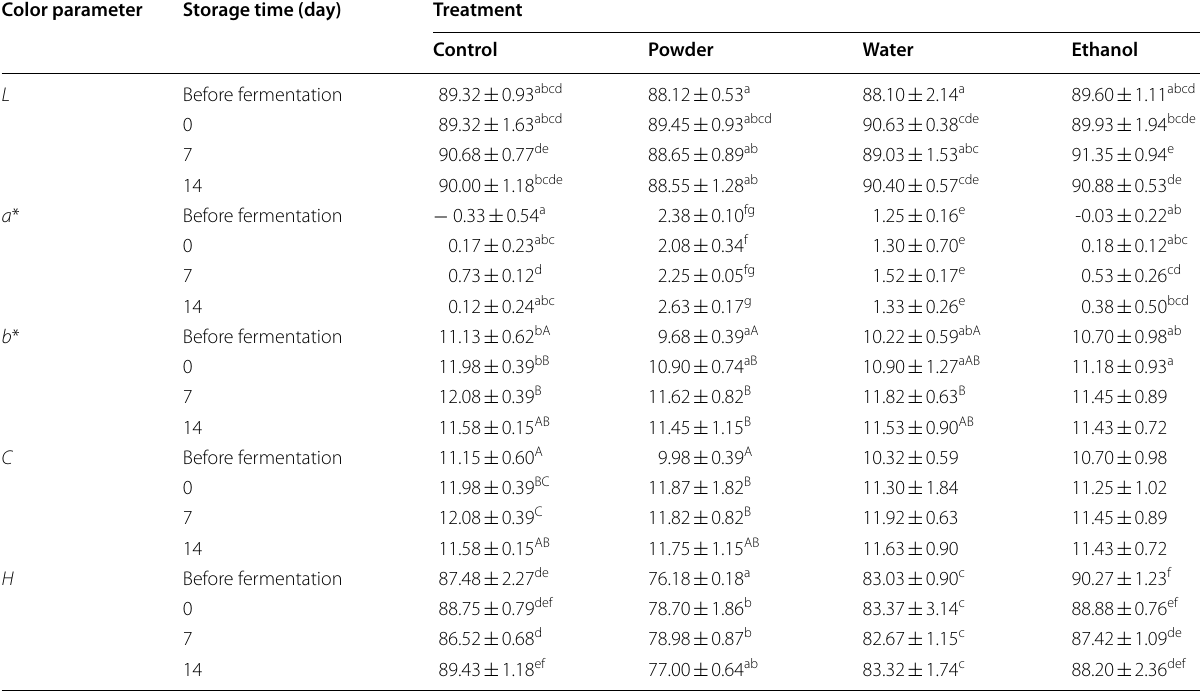
a– f Mean values with different letters are significantly different ( p < 0.05) A, B Mean values in the same column with different letters are significantly different ( p <